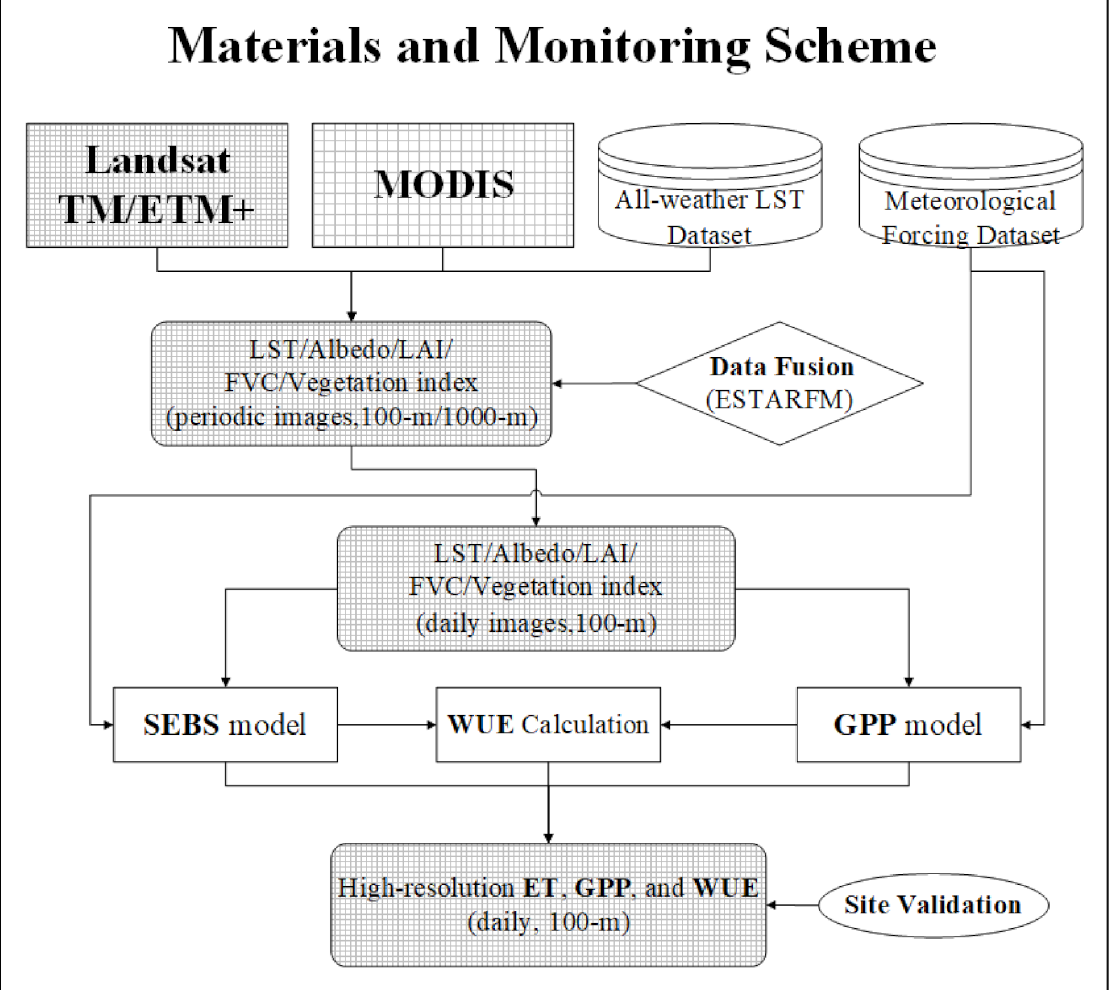
Figure 2. Workflow of information processing used to generate high-resolution (daily, 100 m) ET, GPP, and